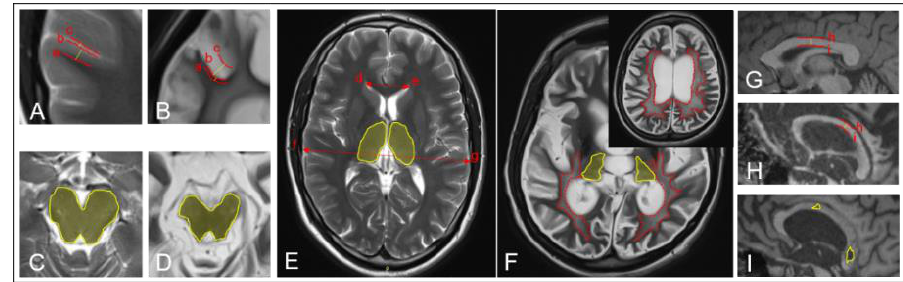
Figure 1. Visualization of scoring parameters on healthy ( A , C , E , G ) and damaged ( B , D , F , H , I ) brain: a-b distance (yellow line between a and b on A,B)—cortical thickness; b-c distance (yellow line between b and c on A,B)—sulcal width; yellow marked areas on C,D—preserved ( C ) and degenerated ( D ) brainstem; yellow marked areas on E,F—preserved ( E ) and degenerated ( F ) thalamus; d-e distance to f-g distance ratio on E—Evans index calculation for ventricular enlargement measuring; red dotted line marked areas on F—confluent areas of leukoaraiosis; h-i distance (yellow line between h and I on G,H)—thickness of corpus callosum central part; yellow marked areas on I—hypointense corpus callosum lesions.